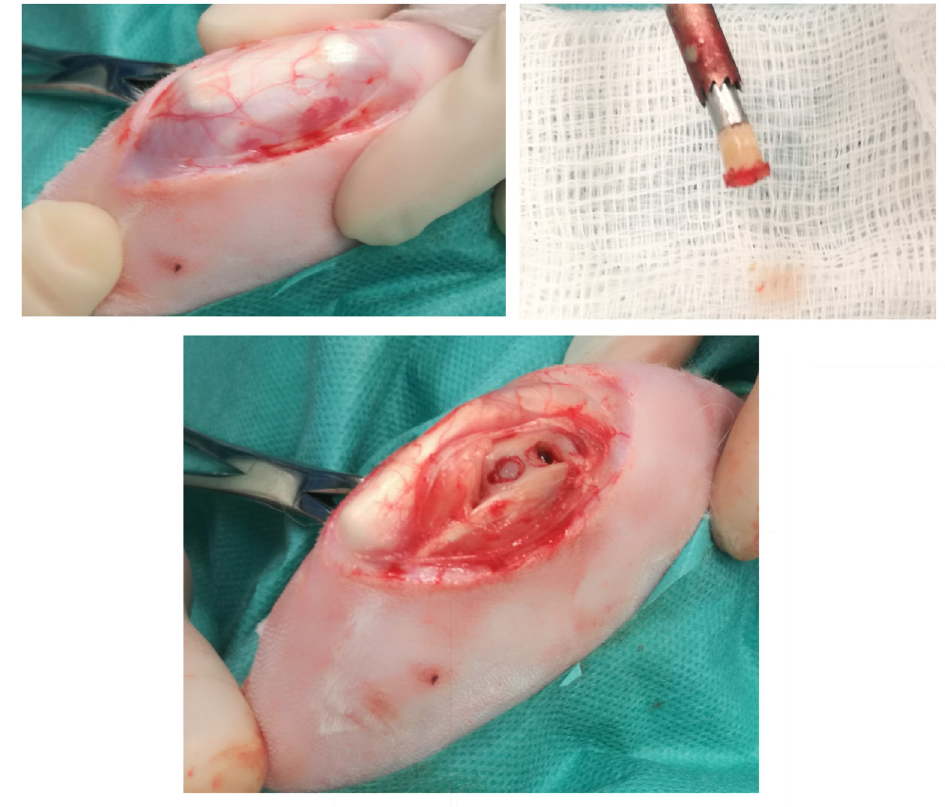
Figure 3. Autologous osteochondral grafting in a rabbit model.